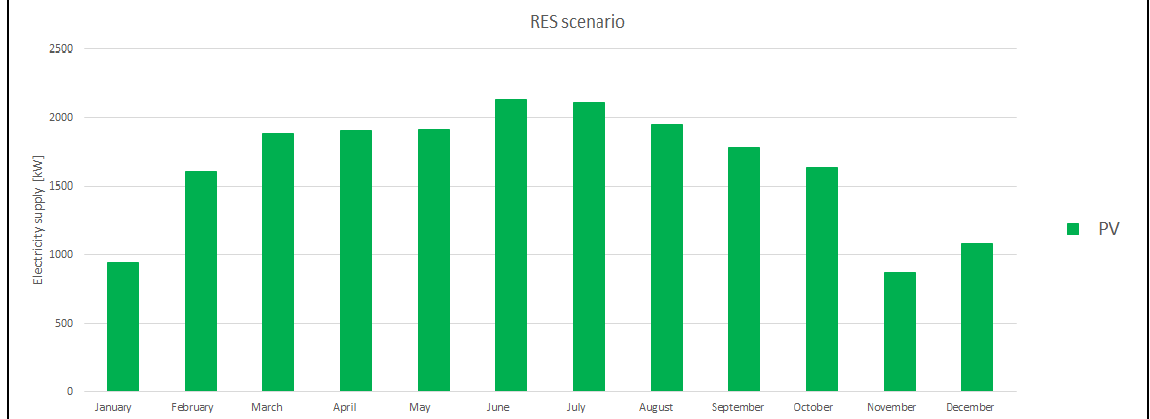
Figure 7. Average PV systems’ output power values for Scenario 1.